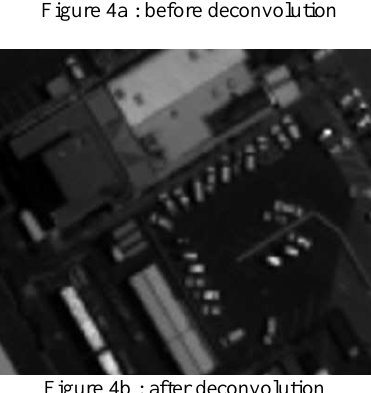
Figure 4b : after deconvolution Figure 4a and 4b points out how image sharpness is efficiently increased by